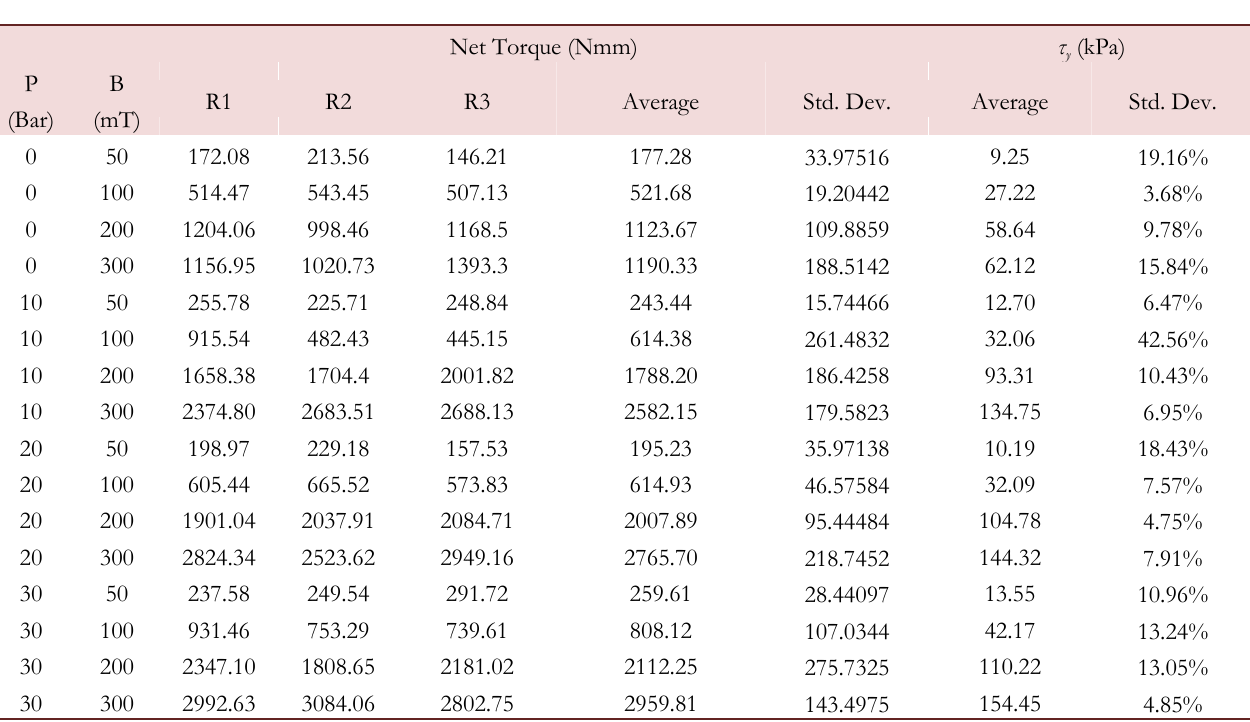
Table 3: Experimental net torque and yield shear stresses τ